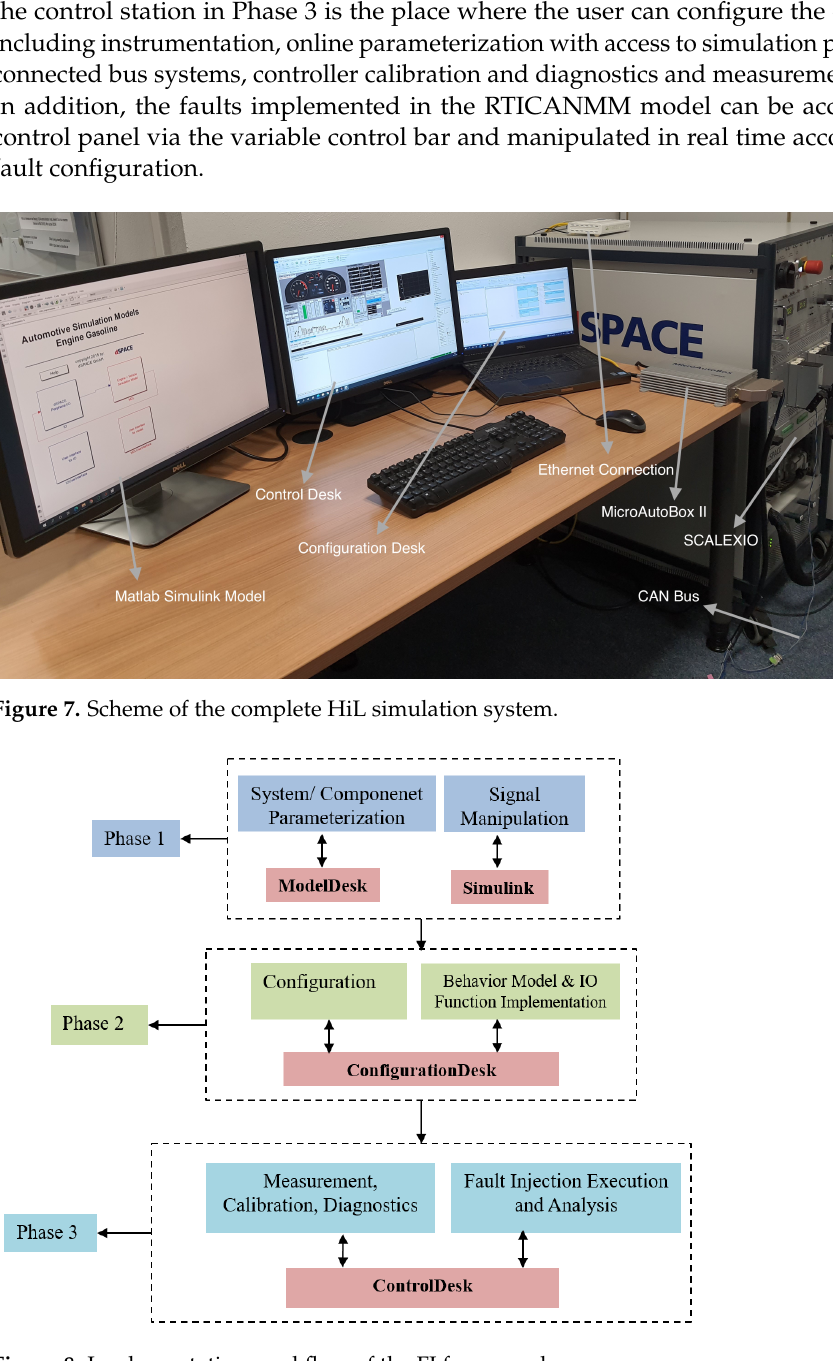
Figure 8. Implementation workflow of the FI